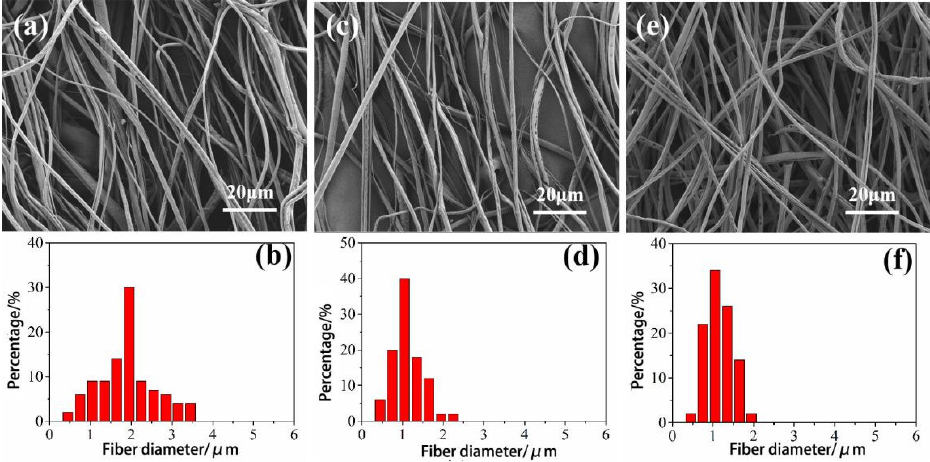
Figure 6. SEM images and fiber diameter distribution diagrams of CA fibers spun at different speeds. ( a , b ): 6000 r/min; ( c , d ): 8000 r/min; ( e , f ): 10,000 r/min.